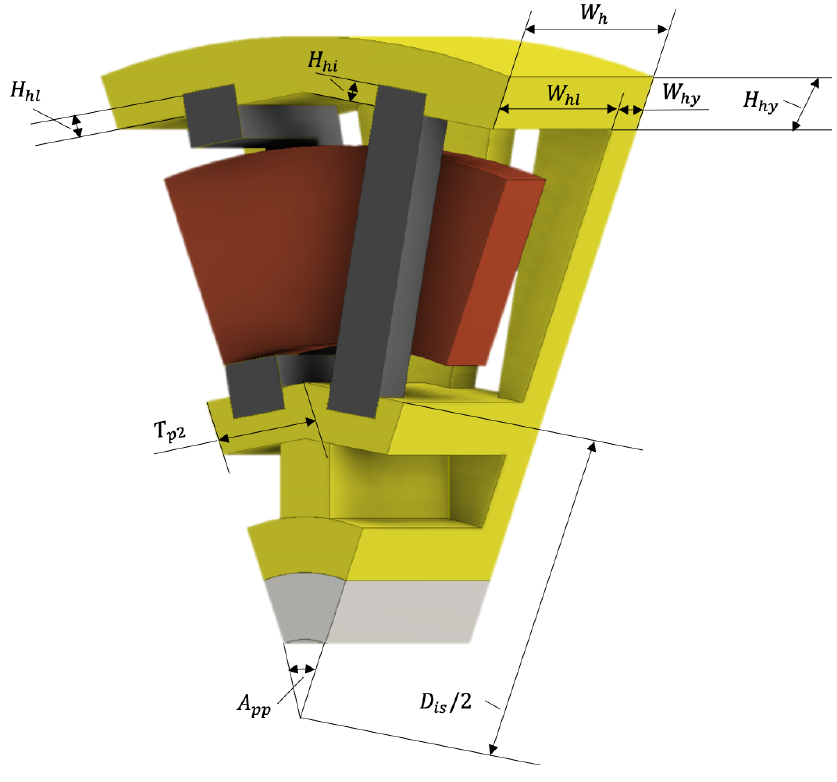
Figure 4. Stator-housing